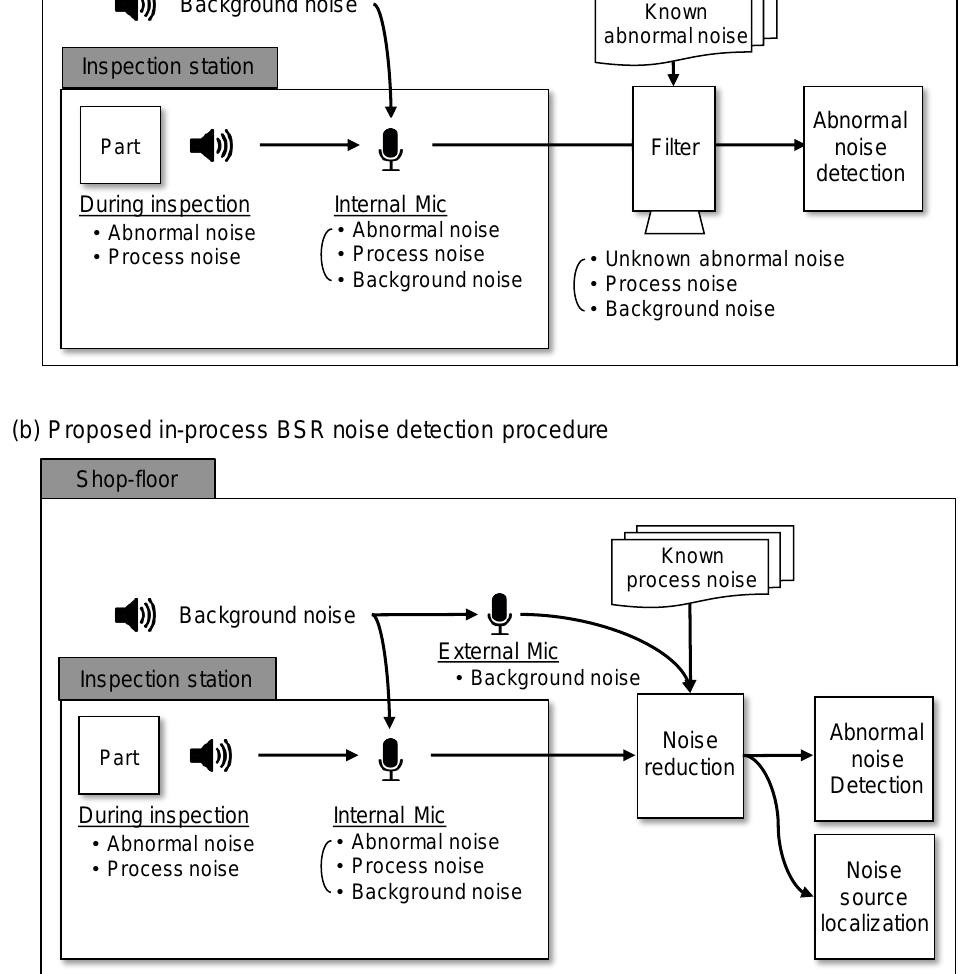
Figure 2. Workflow of BSR noise detection systems: ( a ) conventional and ( b ) proposed in-process BSR noise detection procedures.